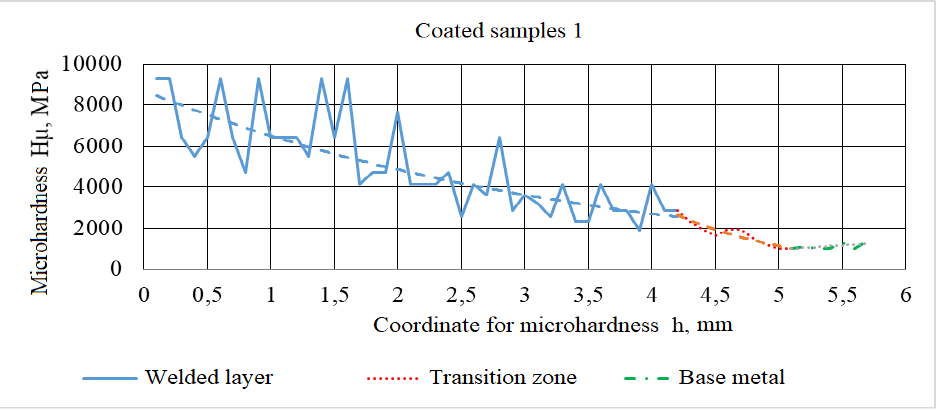
Fig. 3. Microhardness of the sample coated with the composition Fe-Cr-B4C-Mo-C - 2% chromium, 1% boron carbide, 0.5% molybdenum and 0.4% carbon